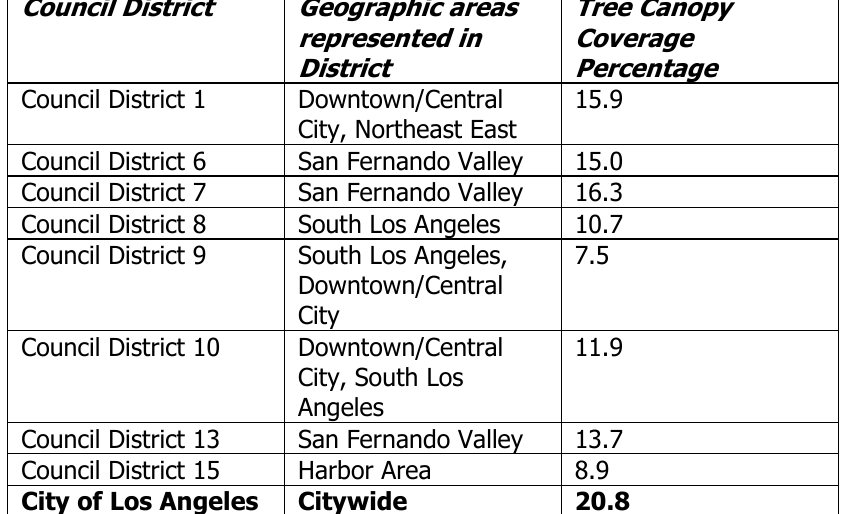
Los Angeles Council districts with low rates of tree canopy coverage (TCC) Council District Geographic